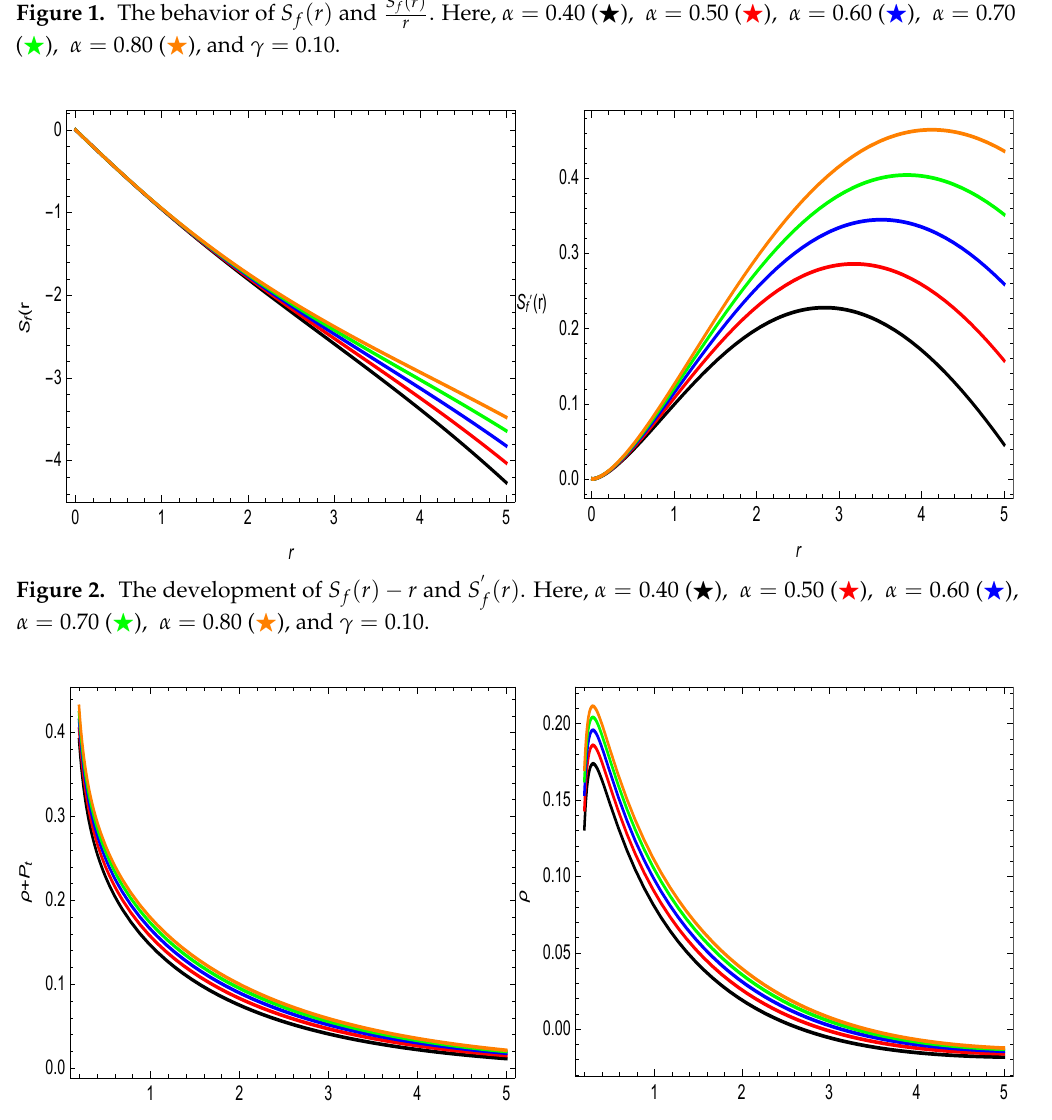
( r ) . Here, α = 0.40 ( (cid:70) ), α = 0.50 ( (cid:70) ), α = 0.60 ( (cid:70) ), α = 0.70 r